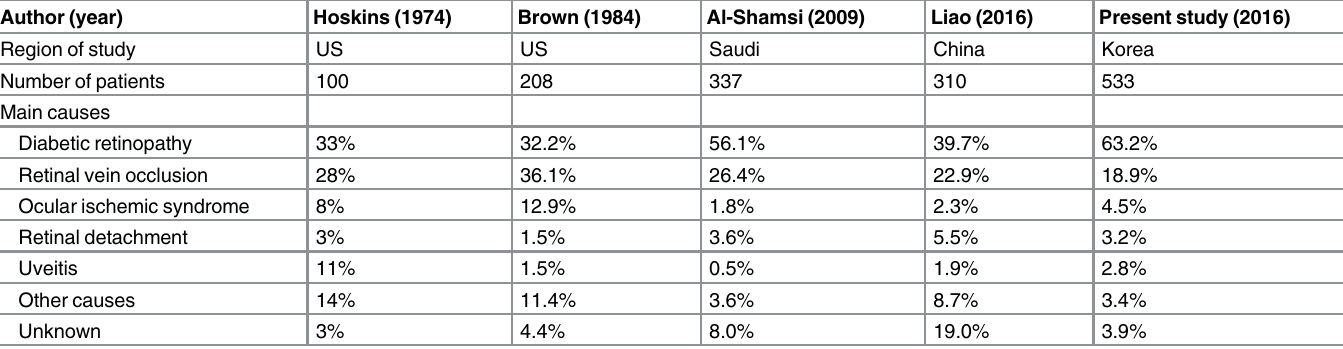
factors of rubeosis iridis or NVG among US patients. One may speculate that etiologic factors Table 3. Comparison of etiologic factors associated with rubeosis iridis among different study populations. Author